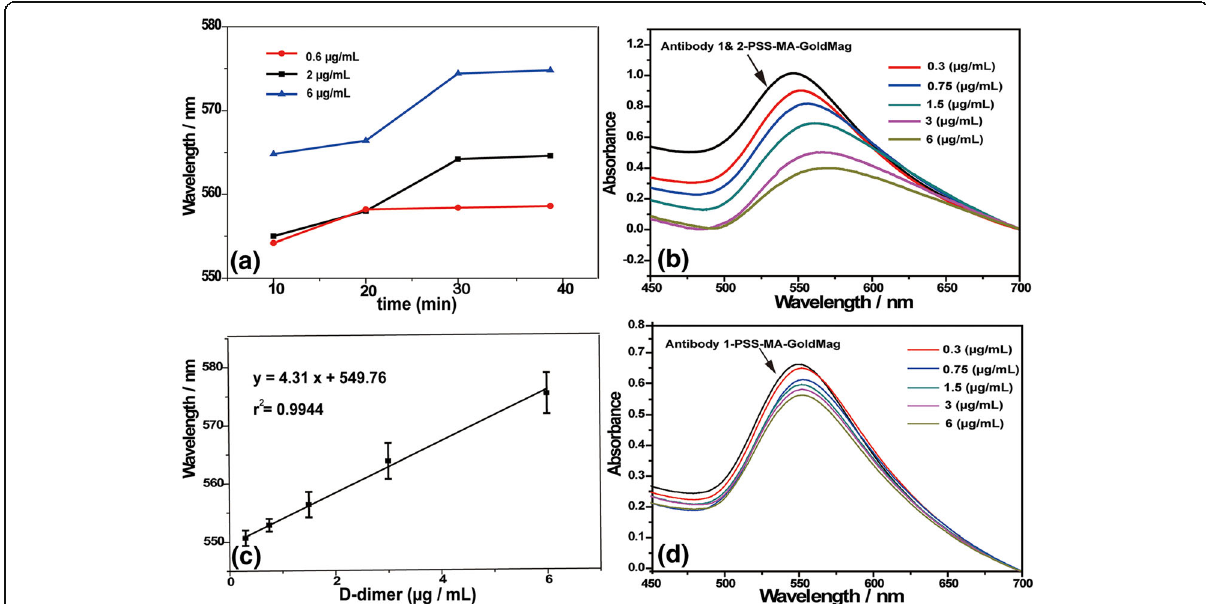
Fig. 5 a The relationship between the reaction time and the SPR spectrum. b The redshift of SPR spectra due to aggregation of GoldMag particles caused by cross connection of D-dimer with probe A. c The curve plotted of the SPR peak of composites as a function of the D-dimer concentration. d The SPR spectroscopy of composites after addition of D-dimer to probe B